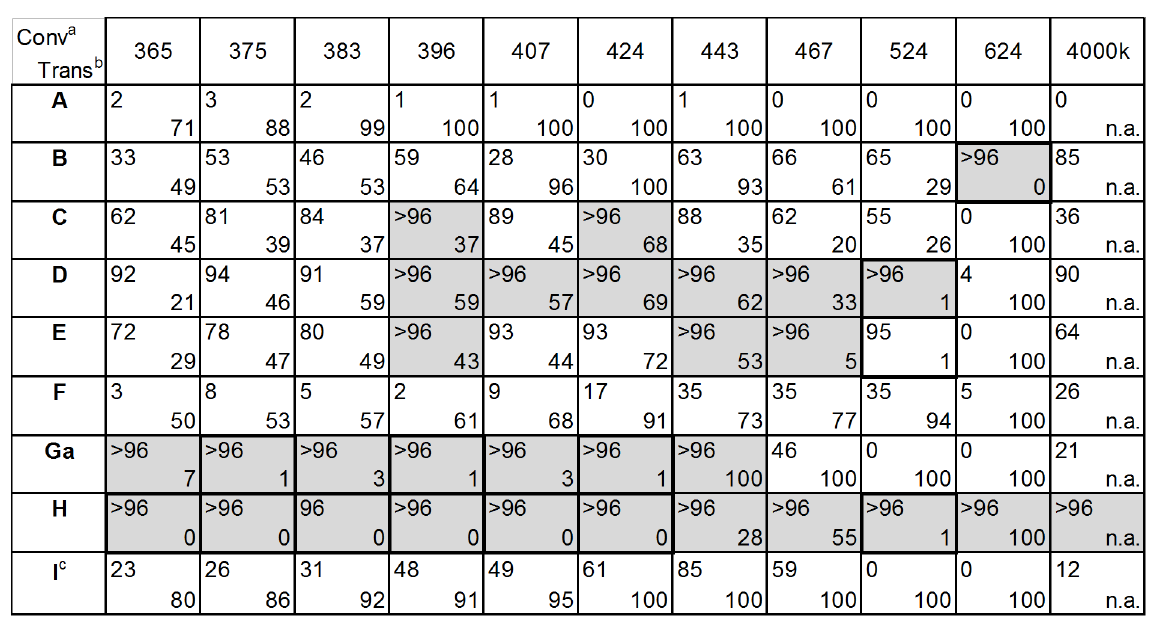
Figure 2: Conversion and transmission at fixed reaction conditions (0.5 N citronellol, 1 mL/min,1 mol % catalyst, 2 equiv oxygen, 8 bar, 20 °C, reactor volume: 2.7 mL, solvent: ethanol ( B , C , D , E , and F ) or dichloromethane ( A , G , H , and I )). a The conversion was determined by GC after quenching with PPh 3 . b Transmission (in %) of the starting solution at 0.5 mm pathlength. c Catalyst concentration: 0.1 mol %.